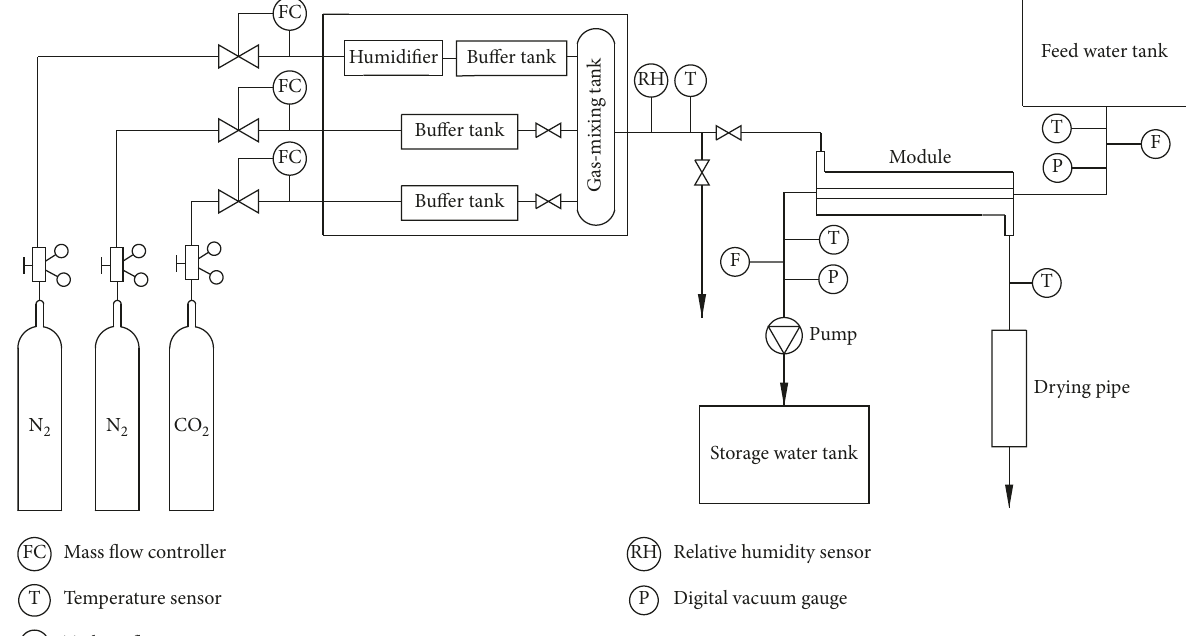
Figure 4: X-ray diffraction patterns of ceramic membranes. (a) X-ray diffraction pattern of the α -Al diffraction pattern of the coal ash ceramic membrane.